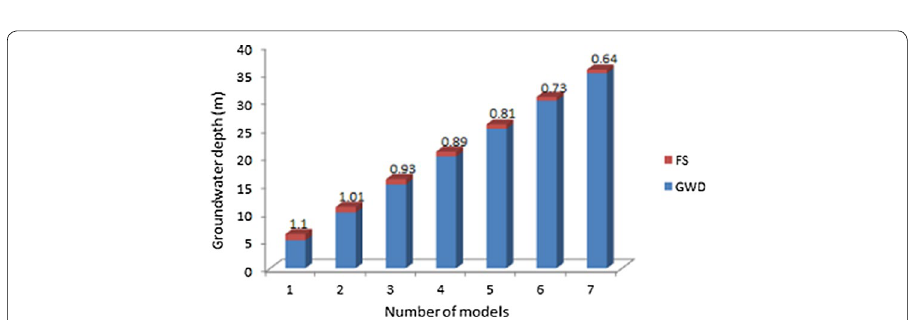
Fig. 14 Effect of groundwater on slope factor of